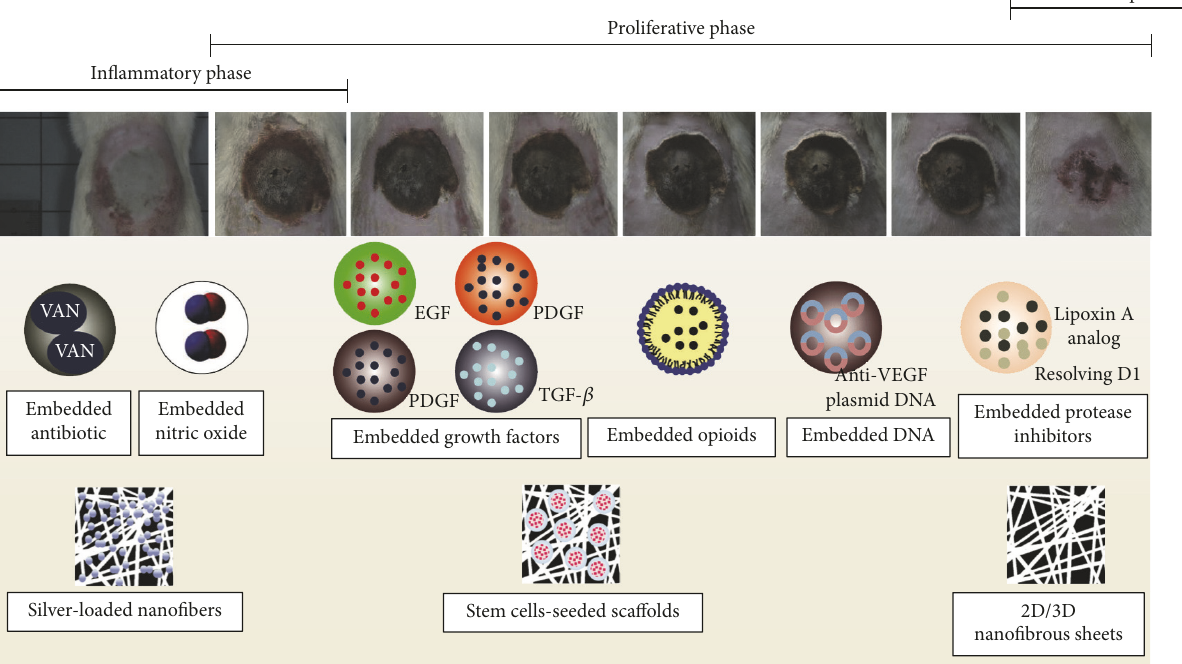
Figure 1: Schematics of current available nanotechnology-based dressing (e.g., nanoparticles and nanofibers) using in different stages of wound healing from an animal model [24, 25] (figure obtained from an open access article distributed under the Creative Commons Attribution